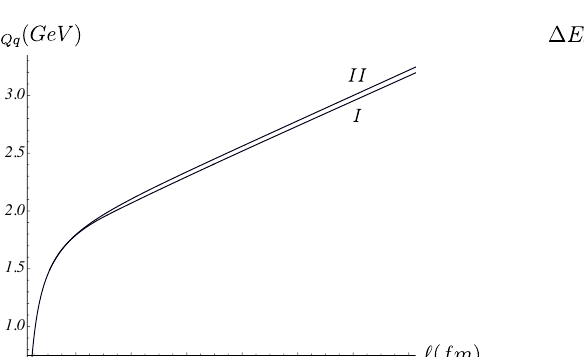
Figure 9 . Left: the energies E (I)